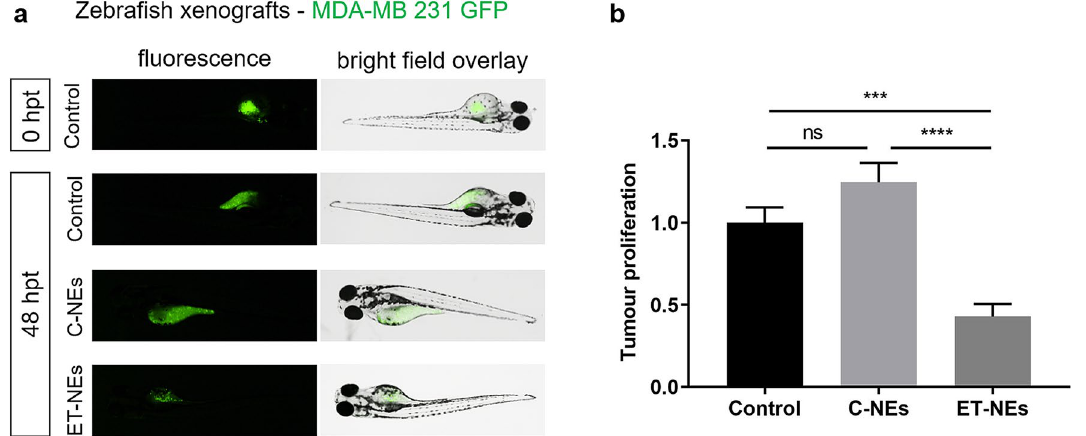
Figure 6. Confocal analysis of tumor cell proliferation in zebrafish ( a ) before (0 hpt) and after 48 hpt. Zebrafish of 48 hpt without chorion were injected with MDA-MB 231 cells expressing GFP and subsequently incubated with ET-NEs and C-NEs at 34 °C. Untreated xenografted embryos were used as control. ( b ) QuantiFish analysis program was used to quantify the fluorescence intensity and determine tumor proliferation. Statistical analysis was performed using One-way ANOVA followed by a Tukey test. P values *** p < 0.001, **** p < 0.0001, ns, not